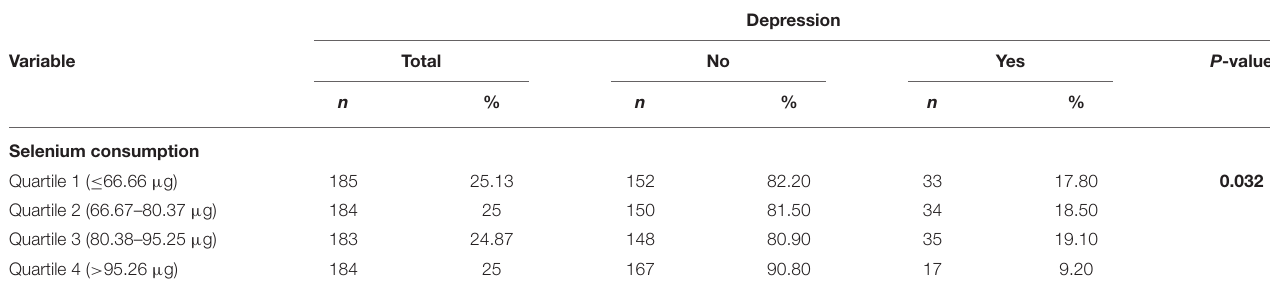
TABLE 2 | Prevalence of depression according to quartile of selenium consumption of Brazilian farmers.